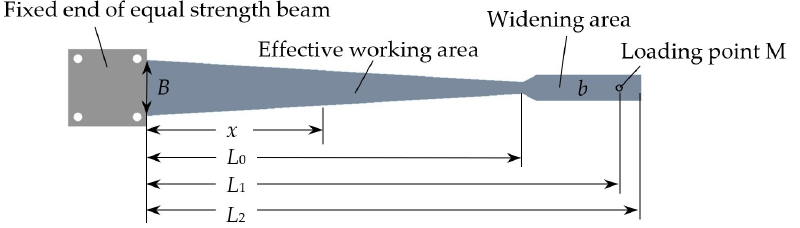
Figure 1. Structure of the equal strength beam. In the figure, B is the width of the effective working area at the fixed end; b is the width of the widening area; x is the distance from any point on the beam to the fixed end; L 0 is the effective length; L 1 is the working length; L 2 is the total length; The thickness of the whole beam is h .